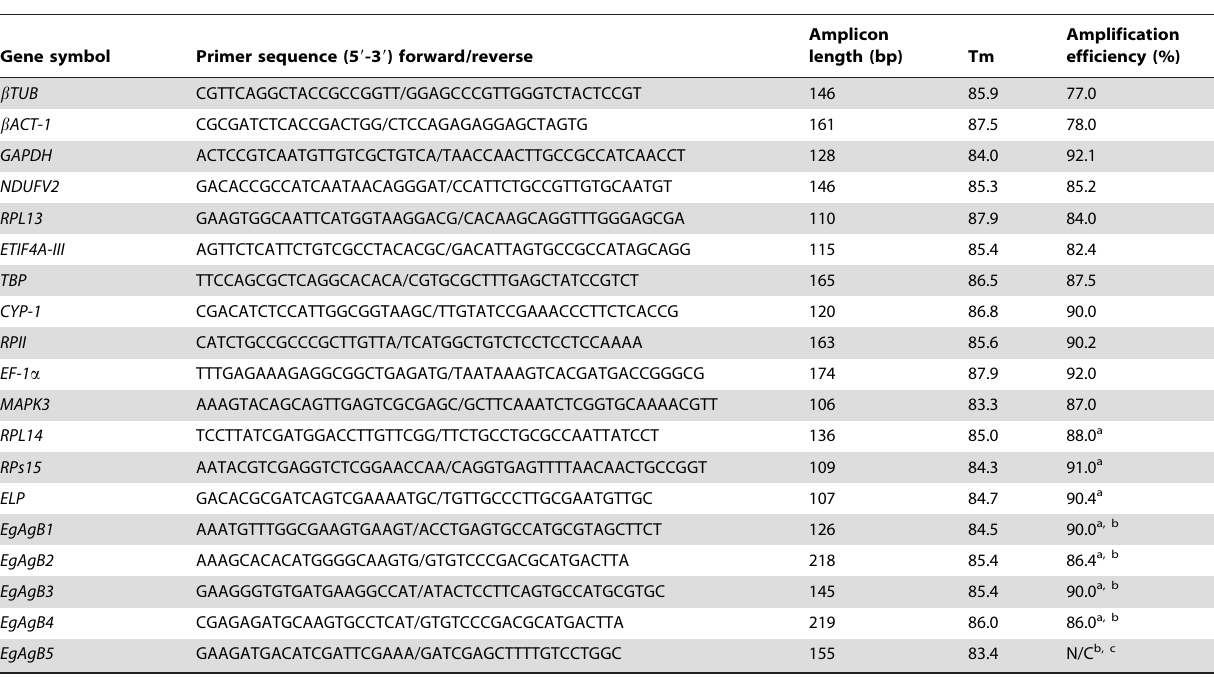
Table 2. Details of each primer designed for the candidate reference genes and target